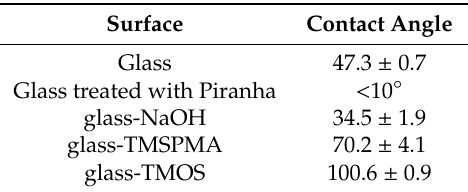
Table 3. Contact angle values of pristine and functionalized glasses. Each value is an average of three